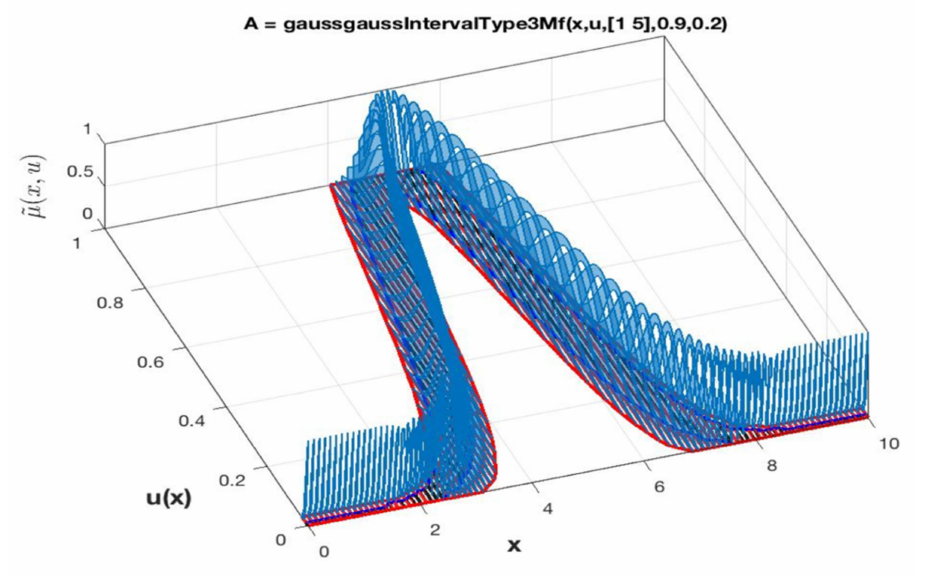
Figure 8. IT3 FS, A , with IT3 MF, (cid:101) µ A ( x , u ) and an embedded vertical cut, µ A ( x (cid:48) ) ( u ) ∈ with the FOU in green color.